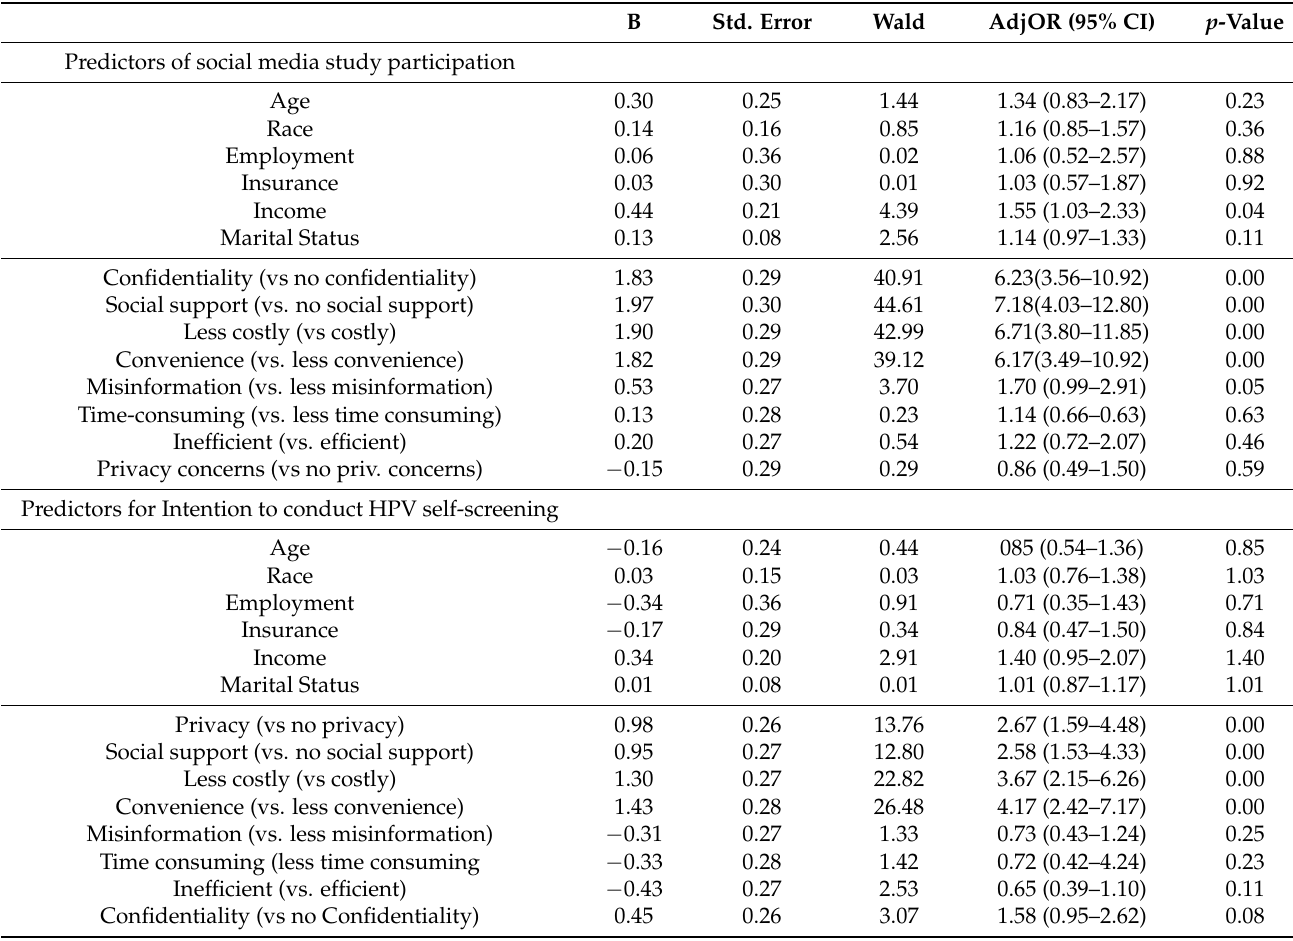
Table 4. Multinomial Logistic Regression Model of Likelihood of participating in social media self-testing and intention for self-testing by selected demographic characteristics ( n = 254).